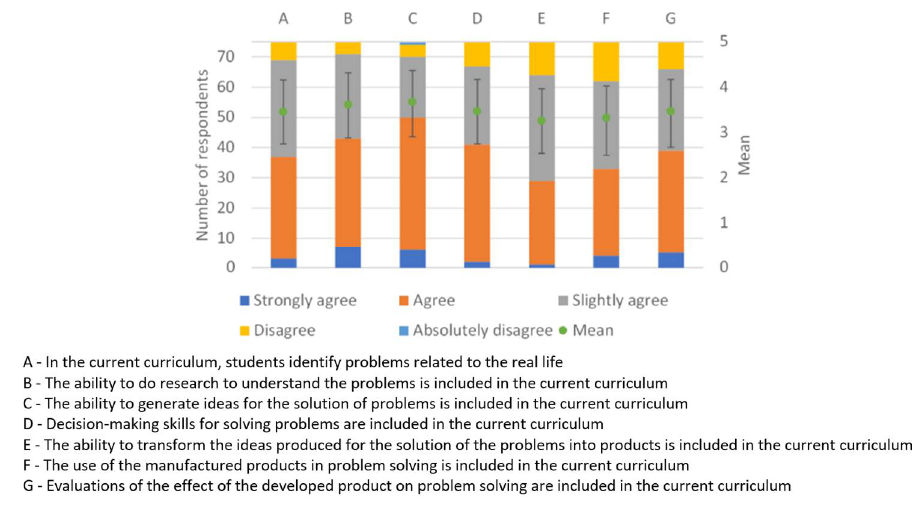
Figure 2. Design thinking skills in the current curriculum (for comments, see the text).